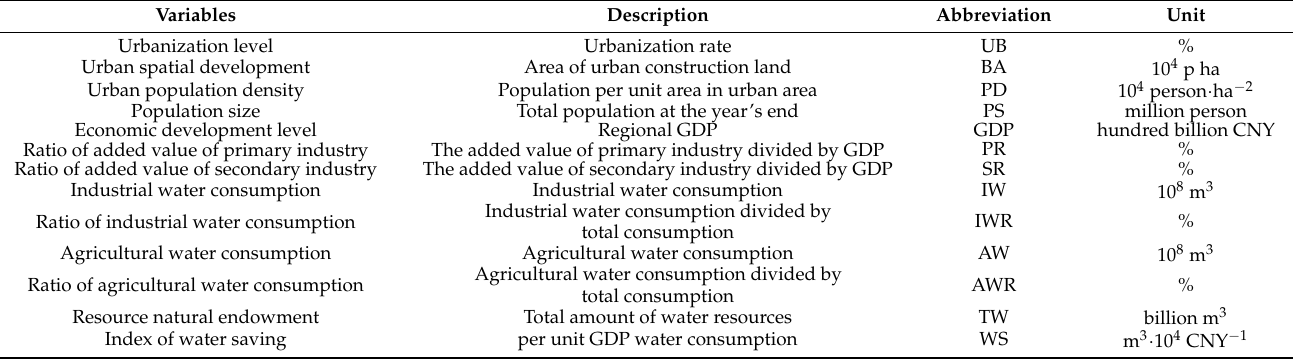
Table 2. Description of Tobit regression variables for water use